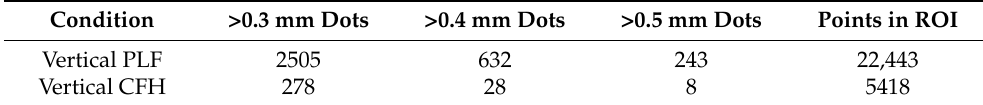
Figure 16. Vertical comparison picture. Table 1. Vertical comparison data table of